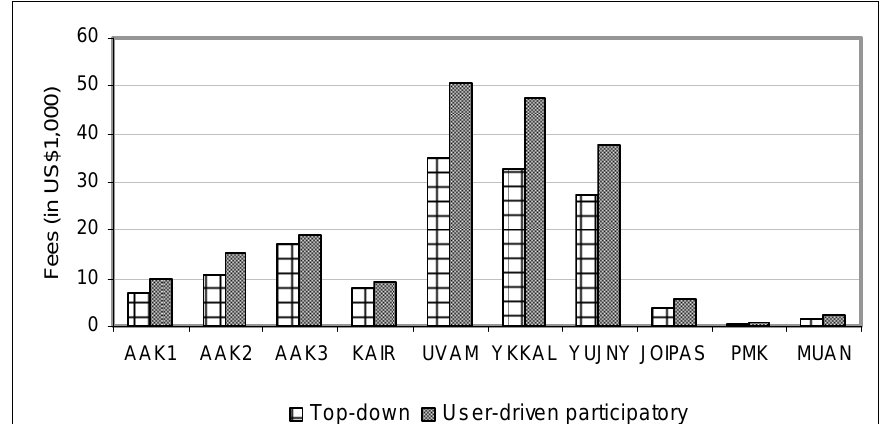
Figure 5. Fee collection under top-down and user participatory water